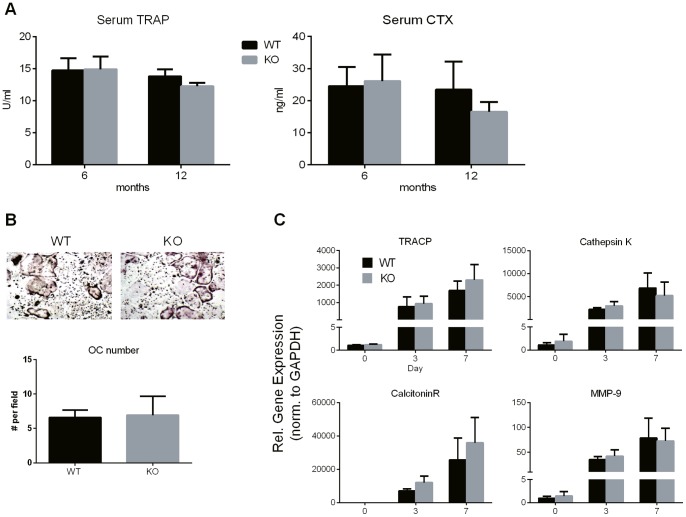
Biomarkers of bone resorption and osteoclast differentiation potential are not affected by Spon1
−
/− deletion.(A) Serum levels of TRAP and CTX-1 in 6 month (n = 12) and 12 month (n = 6) old male mice. (B) In vitro osteoclast differentiation of non-adherent bone marrow cells isolated from male WT and KO littermates. Images show TRAP positive osteoclasts 6 days after stimulation with RANKL and MCSF. Cell numbers represent average counts from 5 separate fields using a 20x objective (n = 4). Only positively stained cells with >3 nuclei were counted. (C) Relative mRNA levels, determined by RT-qPCR of osteoclast marker genes, following induction of differentiation (n = 4). Data represent mean values from 4 littermate pairs.